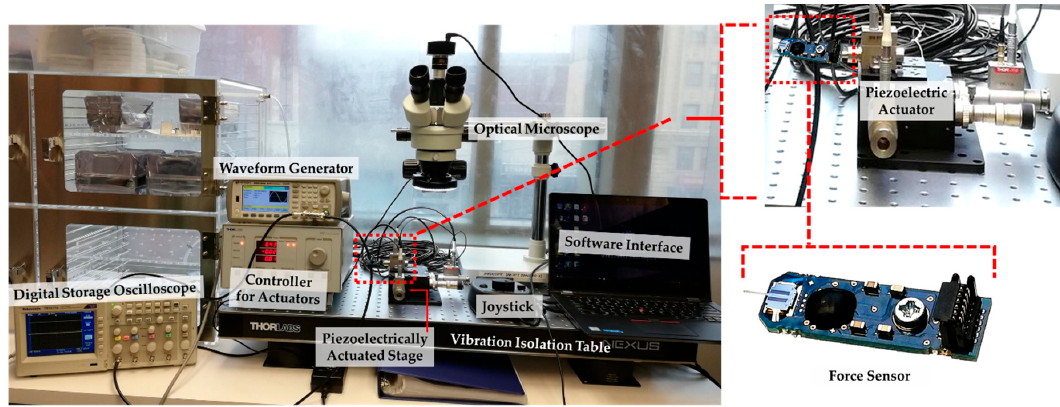
Figure 3. Experimental setup of the piezoelectric actuator and force sensor; inset shows the force sensor.